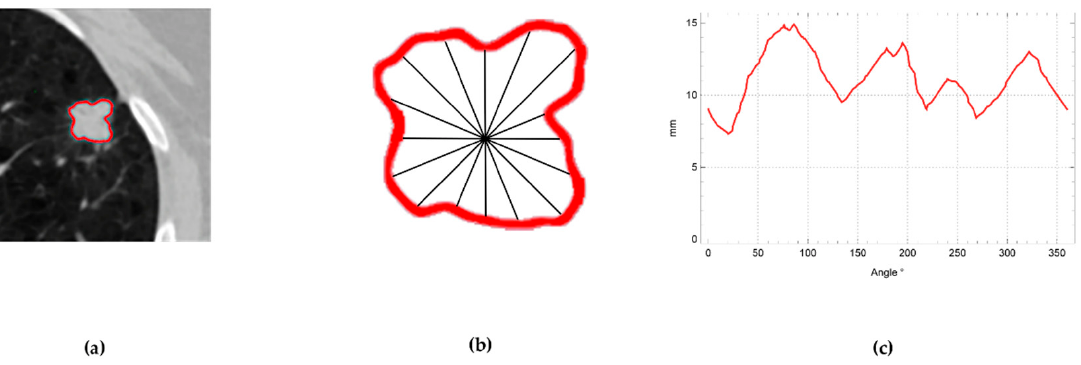
Figure 1. Method of obtaining series by radial